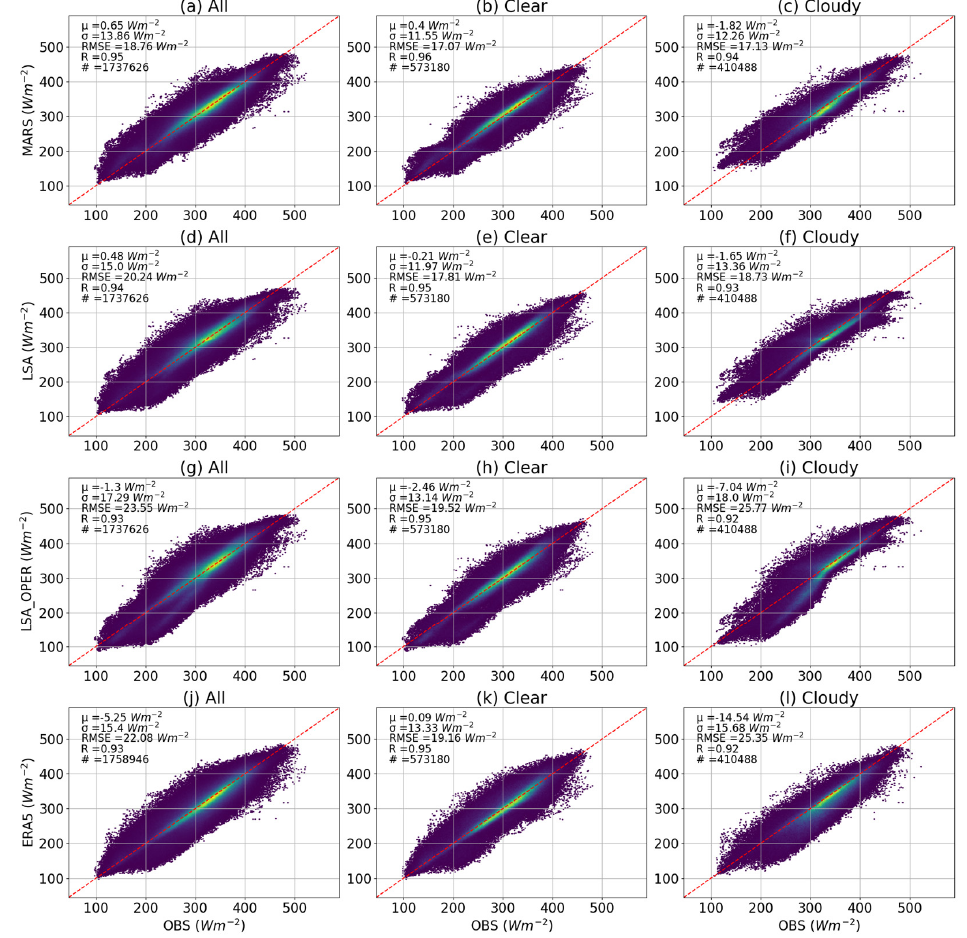
Figure 2. Scatter density plots of the observed DLR fluxes (W · m − 2 ) in the horizontal axis versus the modelled fluxes in the vertical axis for all (left), clear (middle) and cloudy (right) sky conditions estimated with 4 models: MARS ( a – c ), LSA ( d – f ), LSA_OPER ( g – i ), and ERA5 ( j – l ). The evaluation metrics are shown in the top right corner of each plot, including the number of samples used (#). The data represented includes all valid observations for the 23 ground stations in the period 2004–2019. Units are in W · m − 2